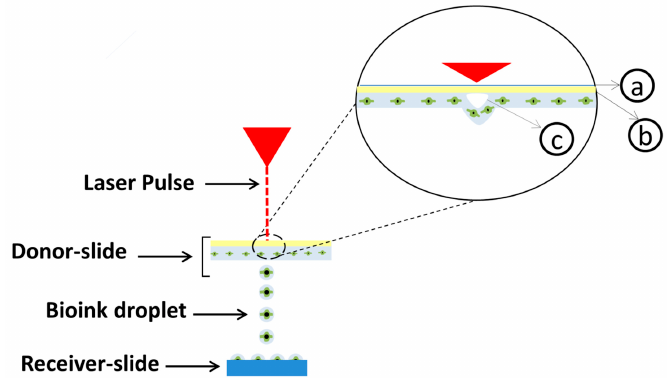
Figure 4. Schematic of Laser-assisted Bioprinting. ( a ) transparent glass, ( b ) thin metal layer, ( c ) vaporization-induced bubble. Bubble nucleation induced by laser energy propels droplets of bioink towards the substrate. This technique has minimal effect on cell viability. A receiver-slide can be a biopaper, polymer sheet or